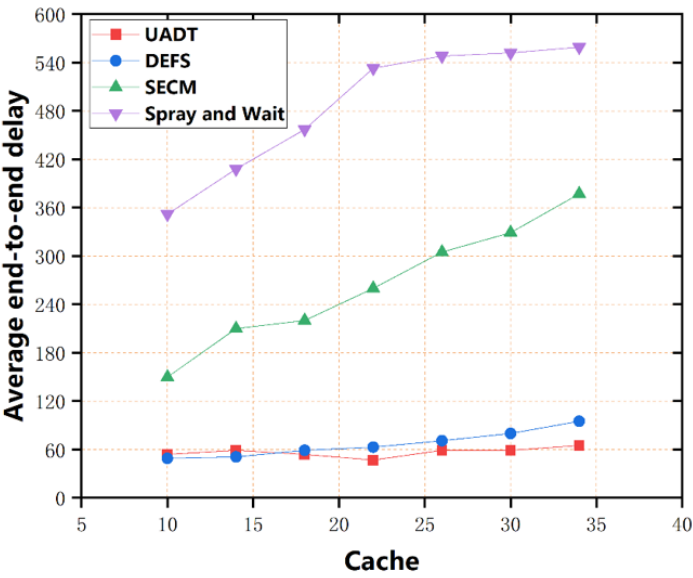
Figure 6. Relationship between energy consumption and cache.